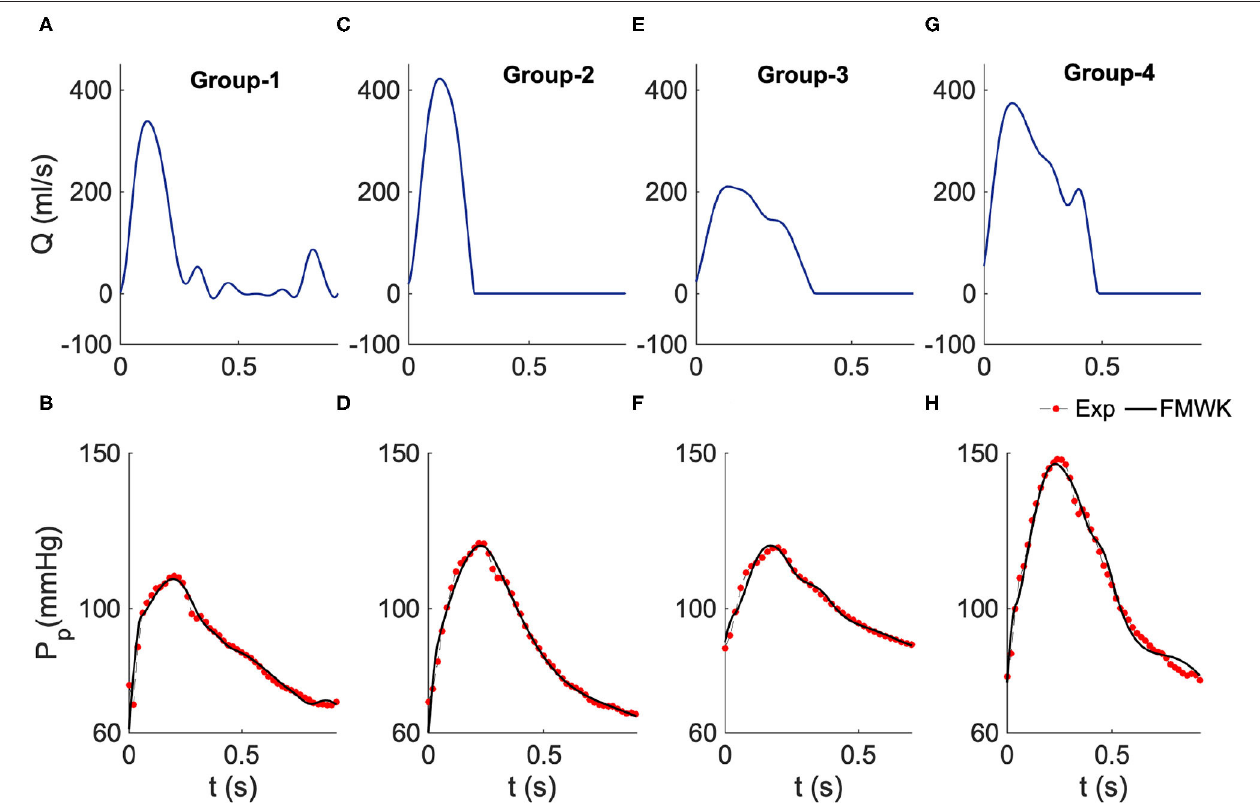
FIGURE 3 | Estimated proximal blood pressure using the proposed fractional-order modified Windkessel model along with the experimental in-vivo human-hypertension for samples from the different groups of the dataset 2. (A,C,E,G) Represent the model input aortic-valve blood flow rate for each group’s sample study, Group 1, Group 2, Group 3 and Group 4, respectively. (B,D,F,H) Represent the pressure waveform validation